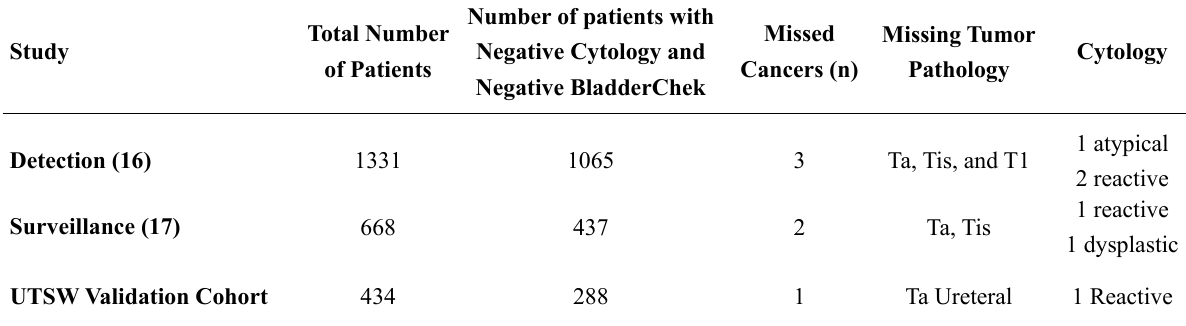
Table 1 - Study Cohorts.